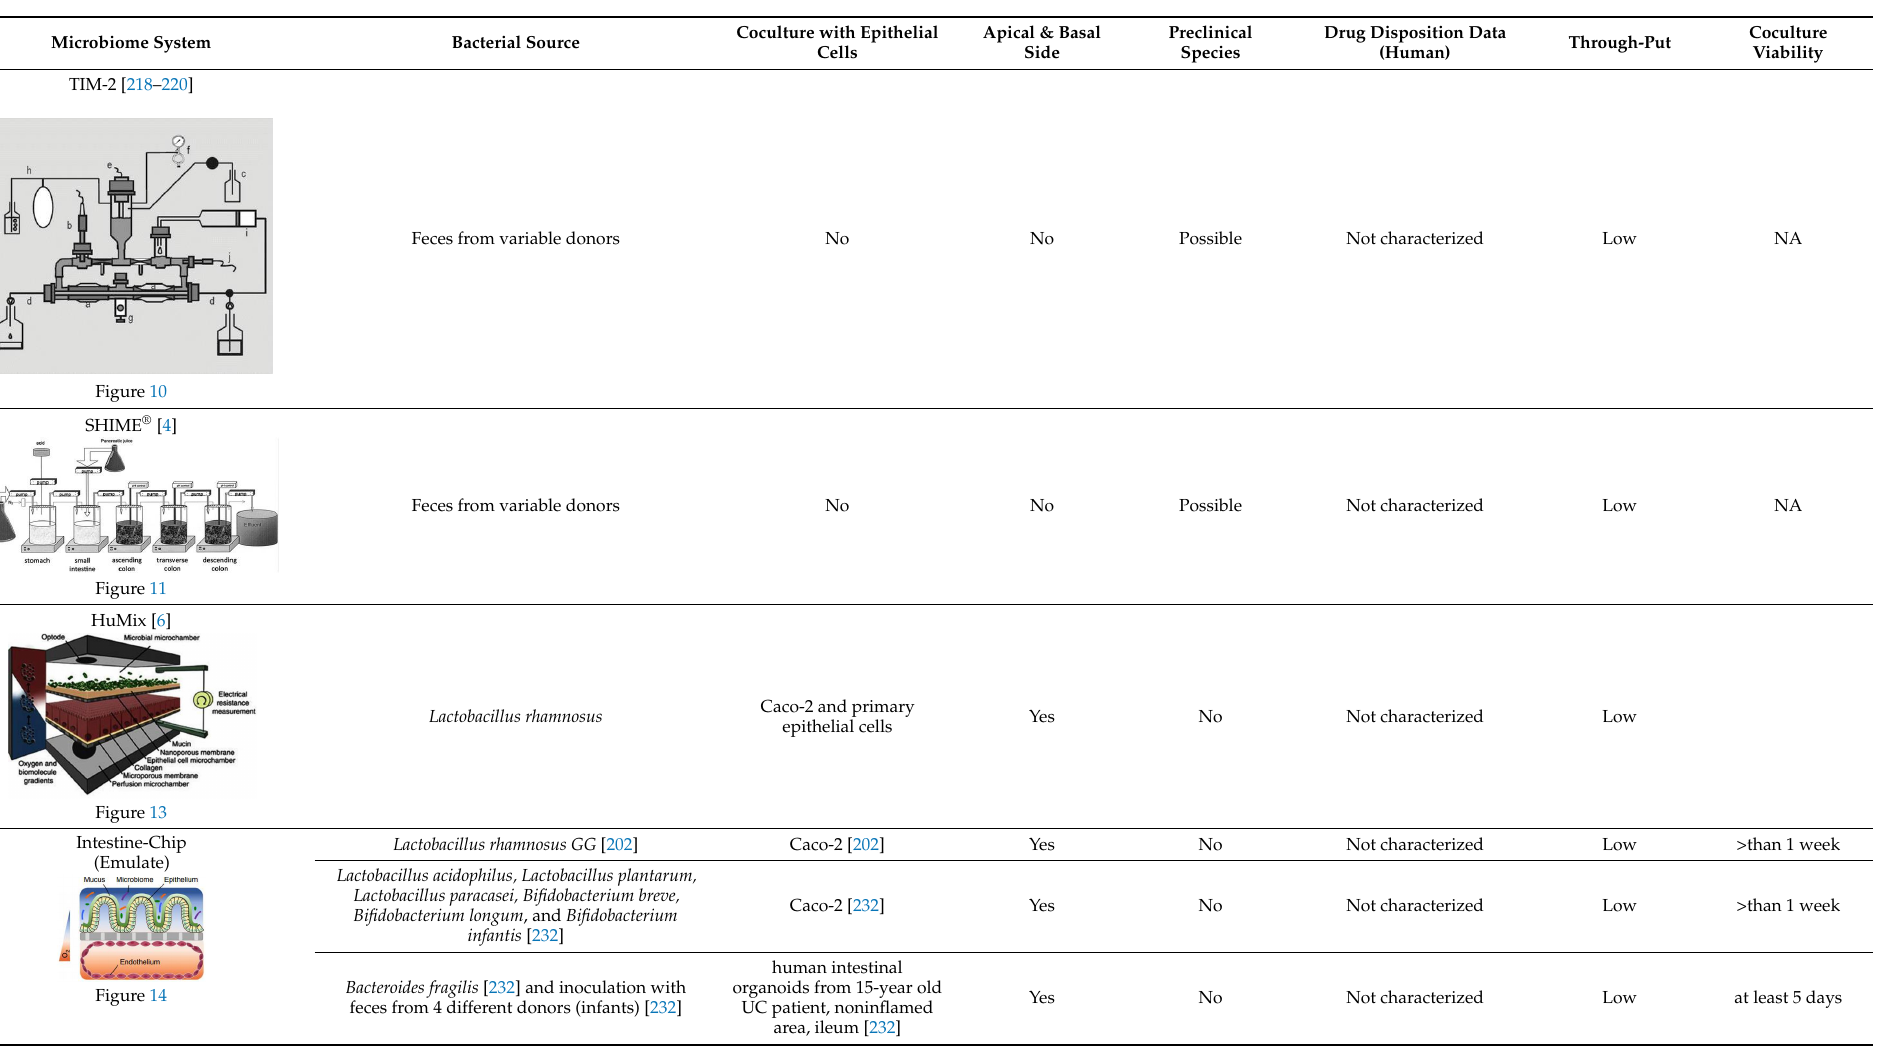
Figure 10. Schematic overview of the Netherlands Organization for Applied Scientific Research (TNO) in vitro model of the colon (TIM-2). (a) peristaltic compartments containing fecal matter; (b) pH electrode; (c) alkali pump; (d) dialysis liquid circuit with hollow fibre membrane; (e) level sen- sor; (f) N 2 gas inlet; (g) sampling port; (h) gas outlet; (i) ‘ileal efflux’ container; (j) temperature sensor. Adopted from [5] , SpringerLink,